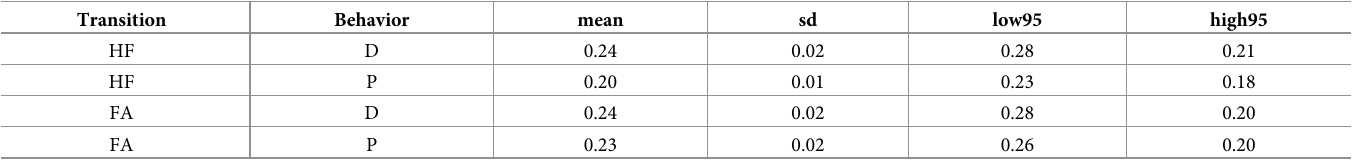
Table 2. Summaries of the proportion of loci that changed methylation status in birds that dispersed (D) or remained philopatric (P) during transitions between the hatchling-fledgling (HF) or fledgling-adult (FA) stage. Values represent the mean, standard deviation (sd) and upper and lower 95% credible intervals from a Bayes- ian